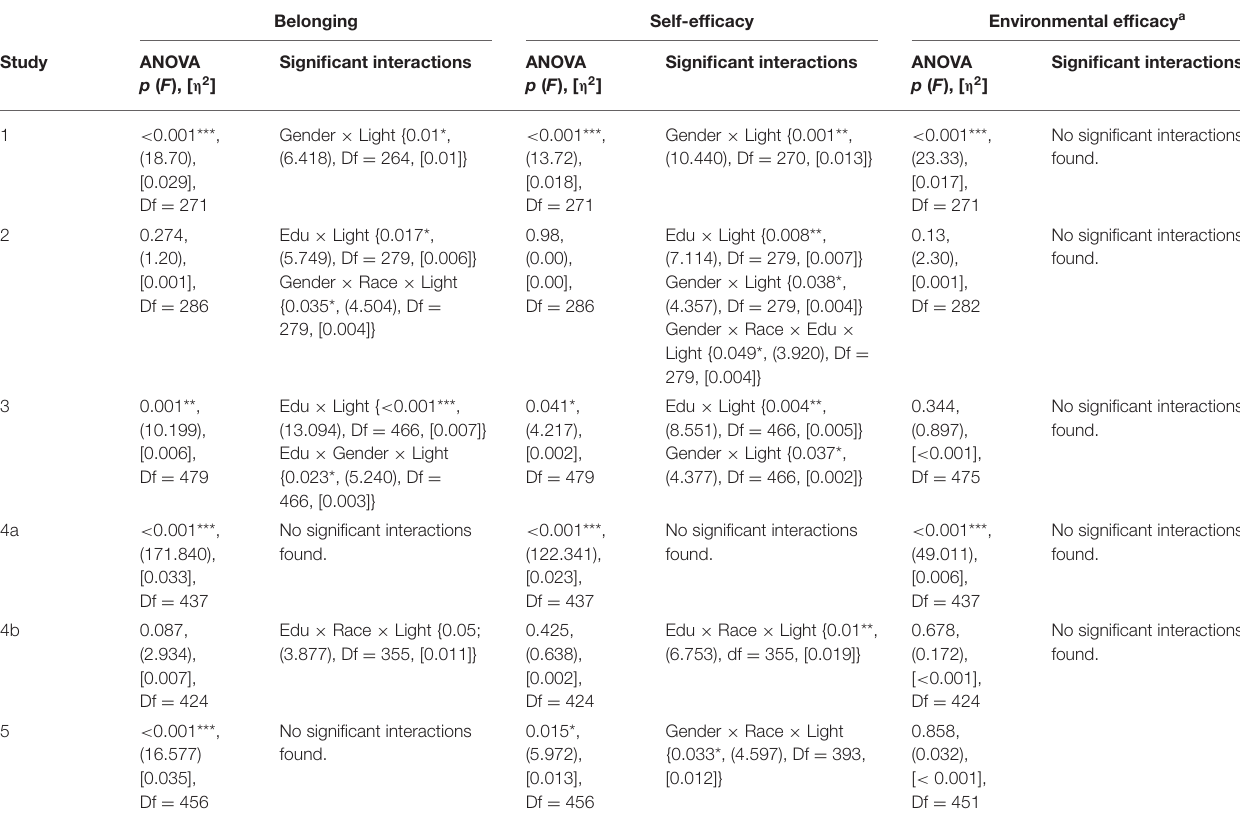
TABLE 6 | ANOVA and mixed ANOVA results for light for all three dependent variables. Belonging Self-efficacy Environmental efficacy a Study ANOVA Significant interactions ANOVA Significant interactions ANOVA Significant p ( F ), [ η 2 ] p ( F ), [ η 2 ] p ( F ), [ η 2 ]